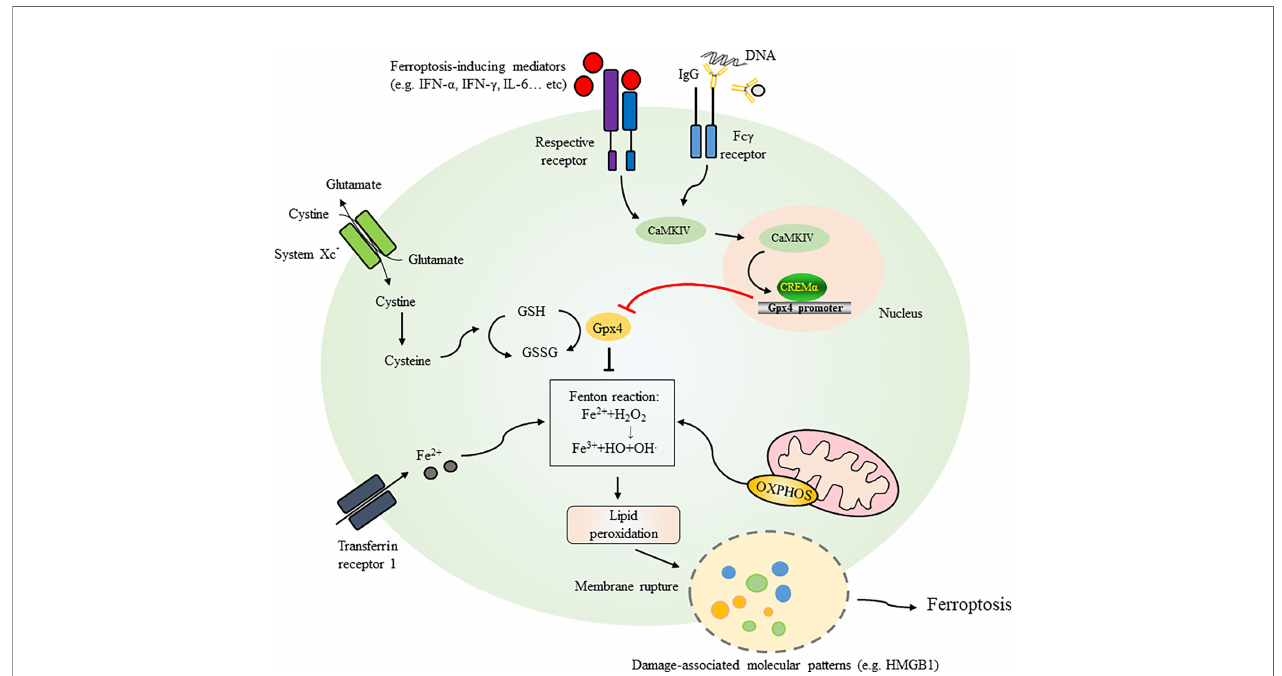
FIGURE 1 | Initiation and mechanisms regulating ferroptosis. Several key factors, including cystine uptake, levels of GSH, and activities of Gpx4, act as crucial regulators counteracting iron-dependent generation of lipid peroxidation products and preventing ferroptosis and plasma membrane damage. One molecule of cystine across plasma membrane with an exchange of one molecule of glutamate through cystine-glutamate antiporter (System Xc -) . Inside the cell, cystine is reduced to cysteine for GSH synthesis. GSH is easily oxidized to the disul fi de dimer GSSG (oxidized form of glutathione). Extracellular iron can be transported to intracellular through transferring protein 1. Iron as an electron carrier also functions as a redox catalyst in the Fenton and Haber-Weiss reactions resulting in the generation of ROS. Mitochondria are critical organelle containing ferroptosis-related genes and regulate generation of lipid peroxides through the electron- transporting chain. Ferroptotic pathway can be initiated by activation of cytokines such as IFN- a , IFN- g and IL-6 or serum IgG (e.g. in SLE patients) leading to the activation of CaMKIV/CREM a axis as an example demonstrated in SLE. Binding of CREM a to Gpx4 promoter resulted in suppression of Gpx4 expression which regulates biosynthesis of GSH. Gpx4 also catalyzes the reduction of oxidized biolipids, that converts toxic lipid hydroperoxides into non-toxic lipid alcohols through its cofactor GSH. Dysregulation of these factors leads to ferroptosis with release of damage-associated molecular patterns like HMGB1 and membrane rupture. GSH, glutathione; GPX4, glutathione peroxidase 4; CaMKIV, Ca 2+ /calmodulin – dependent kinase IV; CREM a , cAMP-responsive element modulator a ; IFN- a , interferon-alpha; IFN- g , interferon-gamma; IL-6, interleukin-6; HMGB1, high mobility group box 1; OXPHOS, oxidative